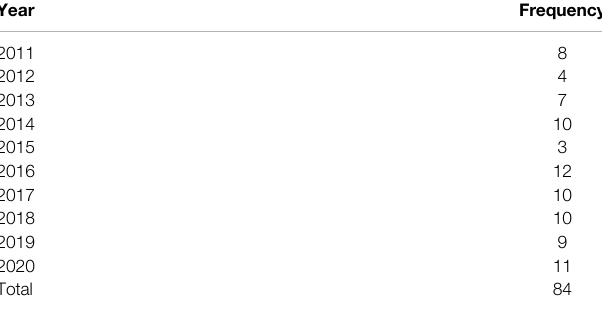
TABLE 2 | Years in which the papers of the fi nal review database were published.